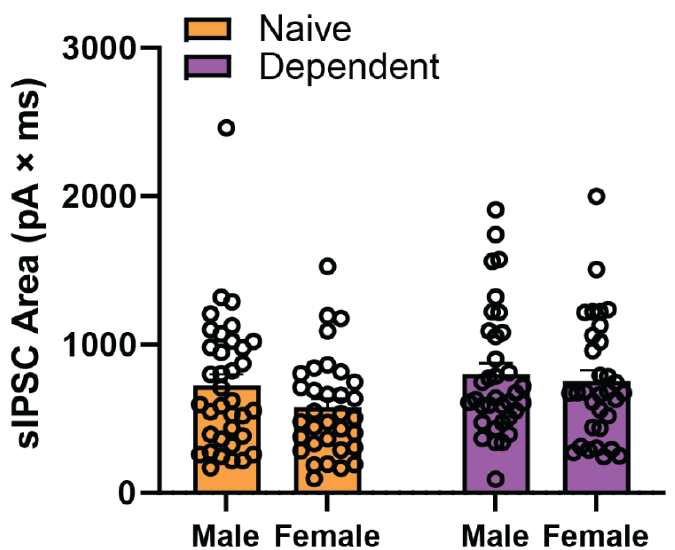
Figure A1. Integrated area of baseline spontaneous inhibitory postsynaptic currents in central amygdala (CeA) of alcohol naïve and alcohol dependent males and females. There were no differences in sIPSC area between the groups. Differences in baseline sIPSC properties are assessed using two-way ANOVA test.; Bars represent Mean ± SEM; n = 31–36 neurons per group; N = 19–25 rats per group.